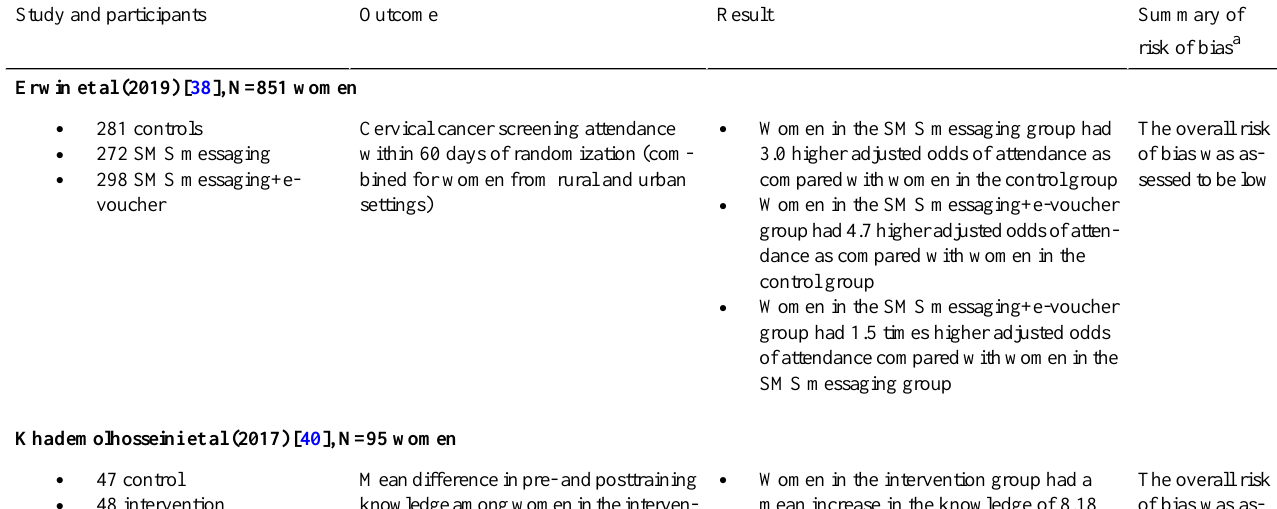
Table 2. Outcomes of randomized controlled trial studies included in the review of primary objectives.